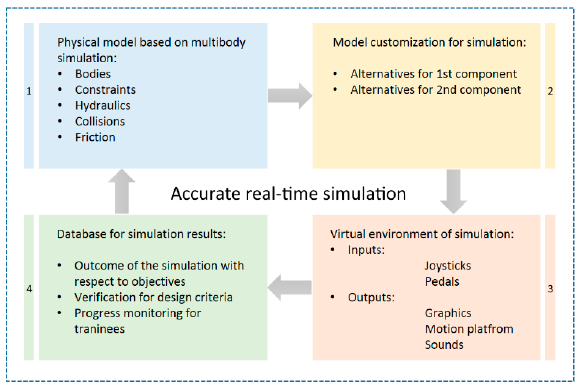
Figure 11. Interaction among components in modeling based on accurate real-time simulation.